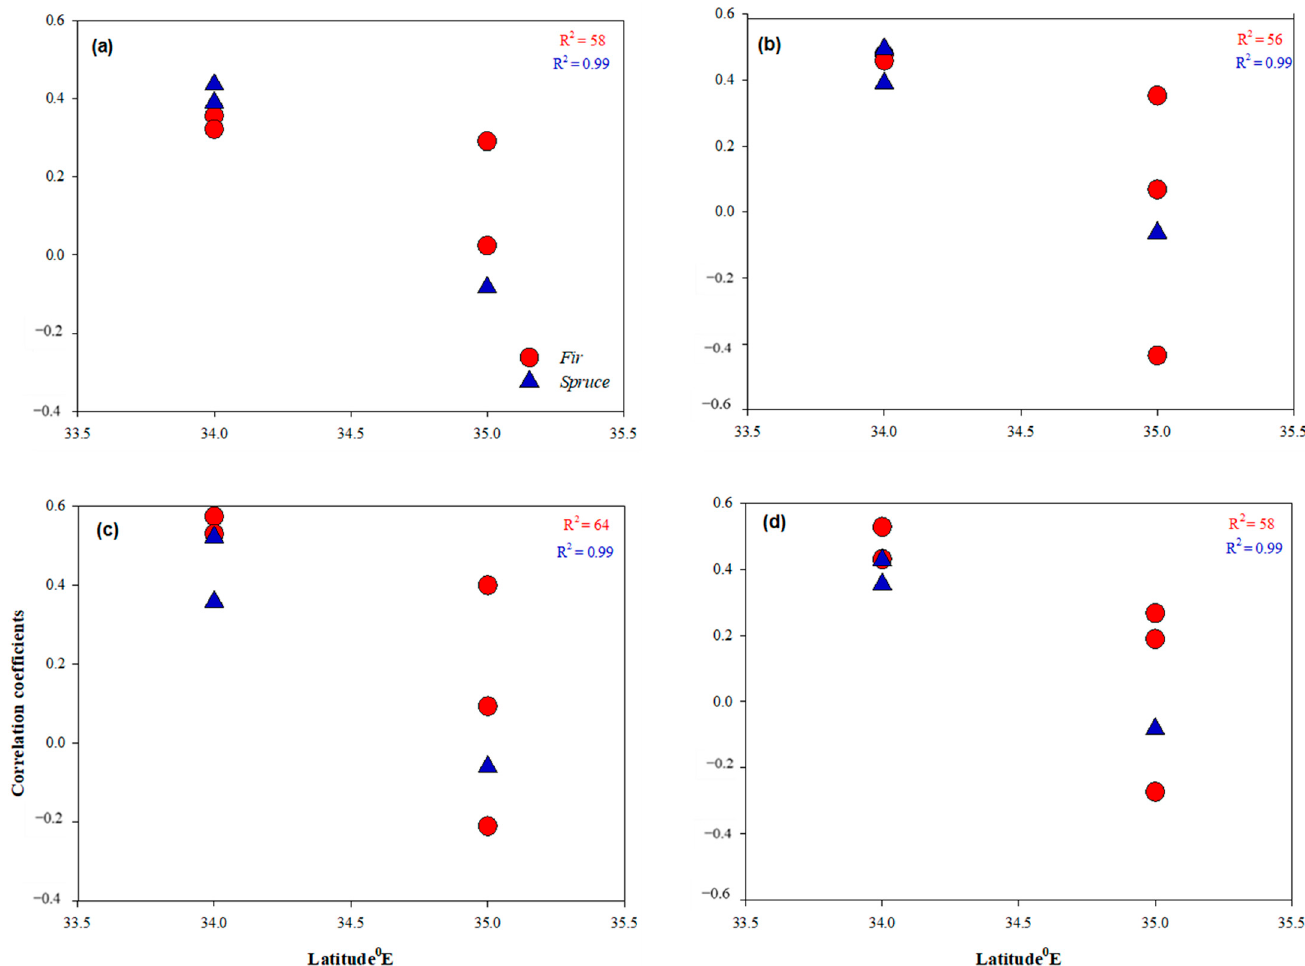
Figure 11. Variation of correlation coefficients between the tree-ring chronologies of spruce (blue triangles) and fir (red dots) and seasonal PDSI with latitudes from 1950 to 2018. ( a ) Winter (Dec–Feb), ( b ) spring (Mar–May), ( c ) summer (Jun–Jul), and ( d ) autumn (Sep–Nov).